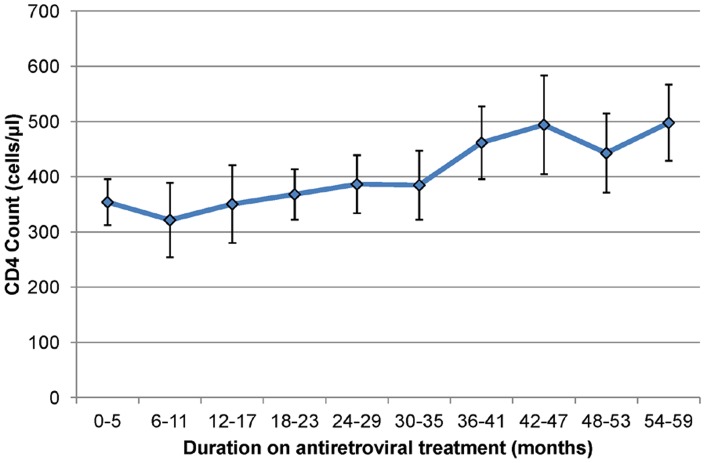
CD4 counts in HIV-positive adults increase after longer durations of antiretroviral treatment.Data points represent mean and whiskers represent 95% confidence intervals of CD4 counts within 6 monthly treatment duration strata.